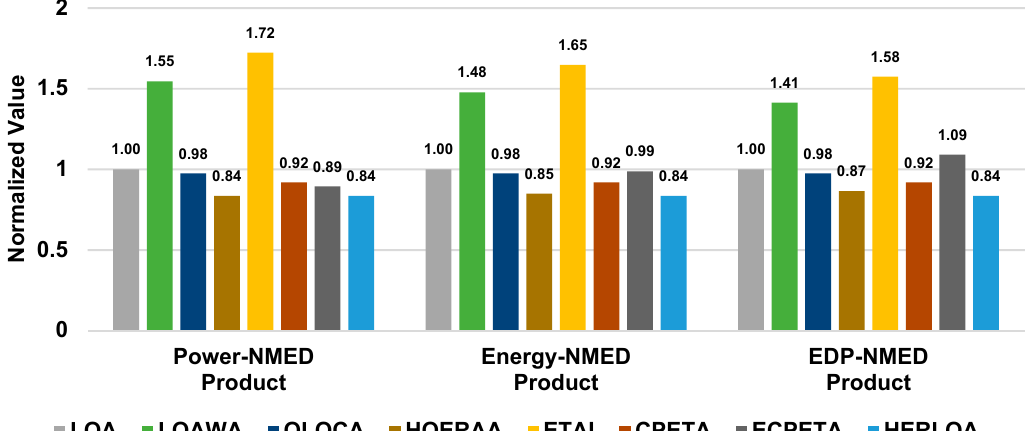
Figure 8. Normalized power-normalized mean error distance (NMED), energy-NMED, and energy-delay product-NMED (EDP-NMED) products of approximate adders with n = 16 and k = 8.